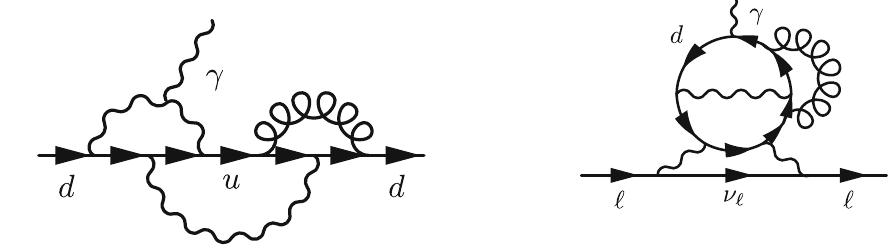
Fig. 1 Representative Feynman diagrams for the leading SM contributions to the quark (left) and the lepton (right) EDMs. For the up-quark EDM the labels d and u have to be exchanged in the left